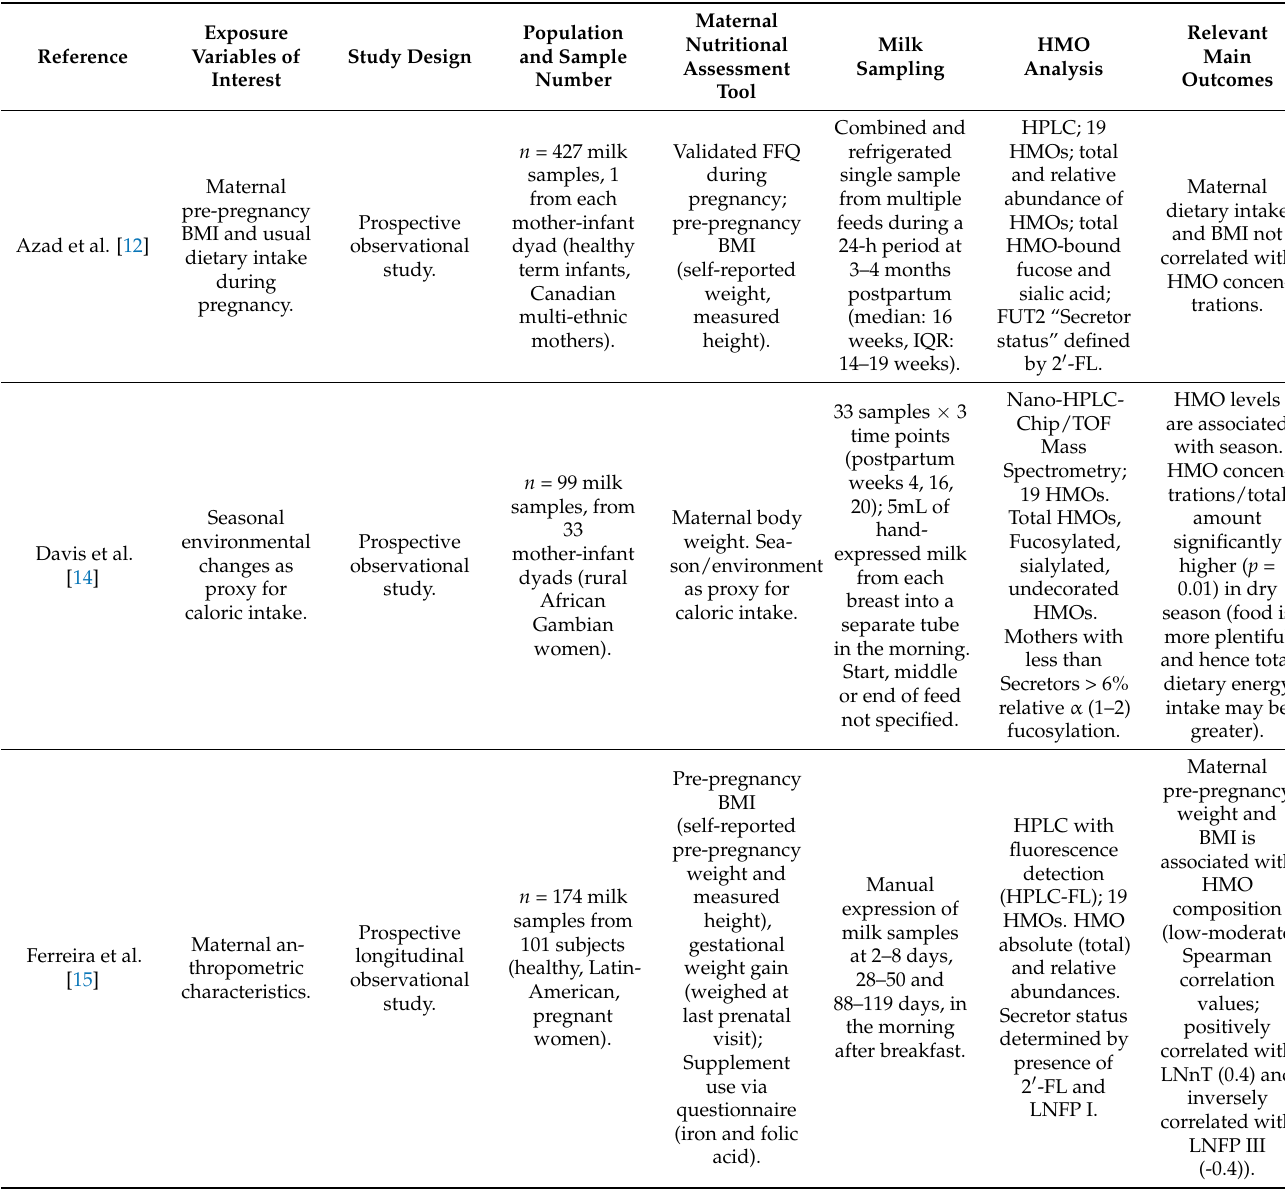
Table 1. Studies evaluating the possible effects of maternal nutrition-related factors on HMO content and